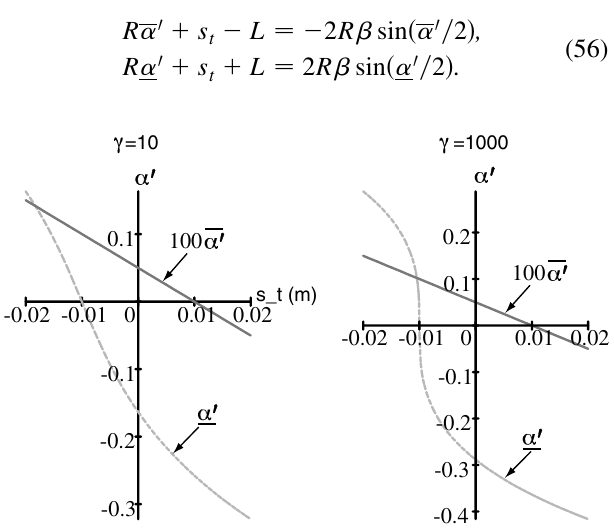
FIG. 8. The effective bunch end point angles % 0 and 100 % 0 , for x (cid:1) y (cid:1) 0 , as determined by Eqs. (56), are plotted against the test point longitudinal coordinate s 0 : 01 m .